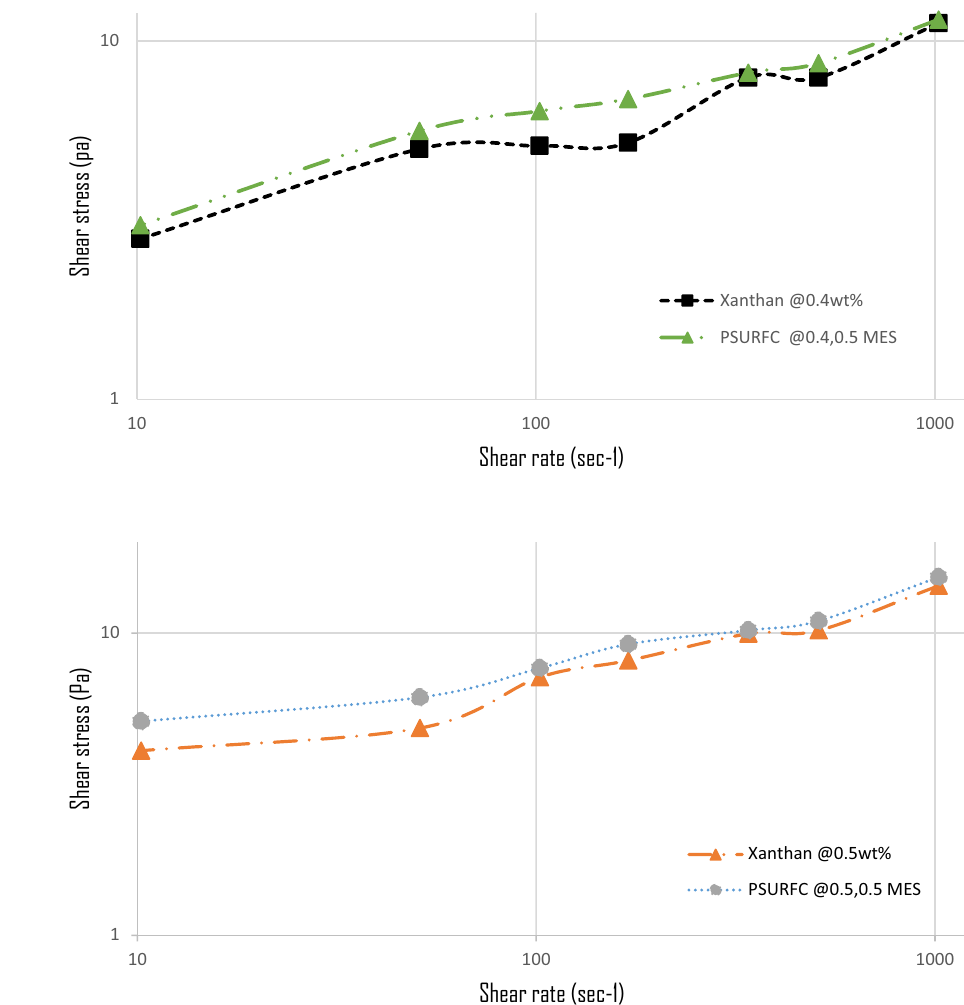
Fig. 5 Shear stress vs. shear